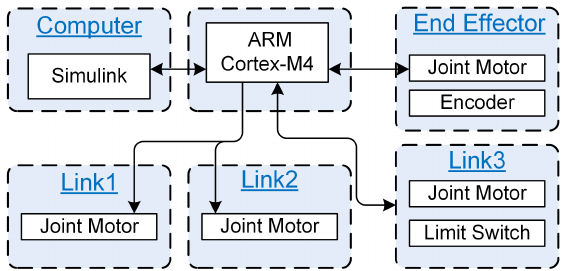
Figure 2. Mechatronic architecture of robotic tail.